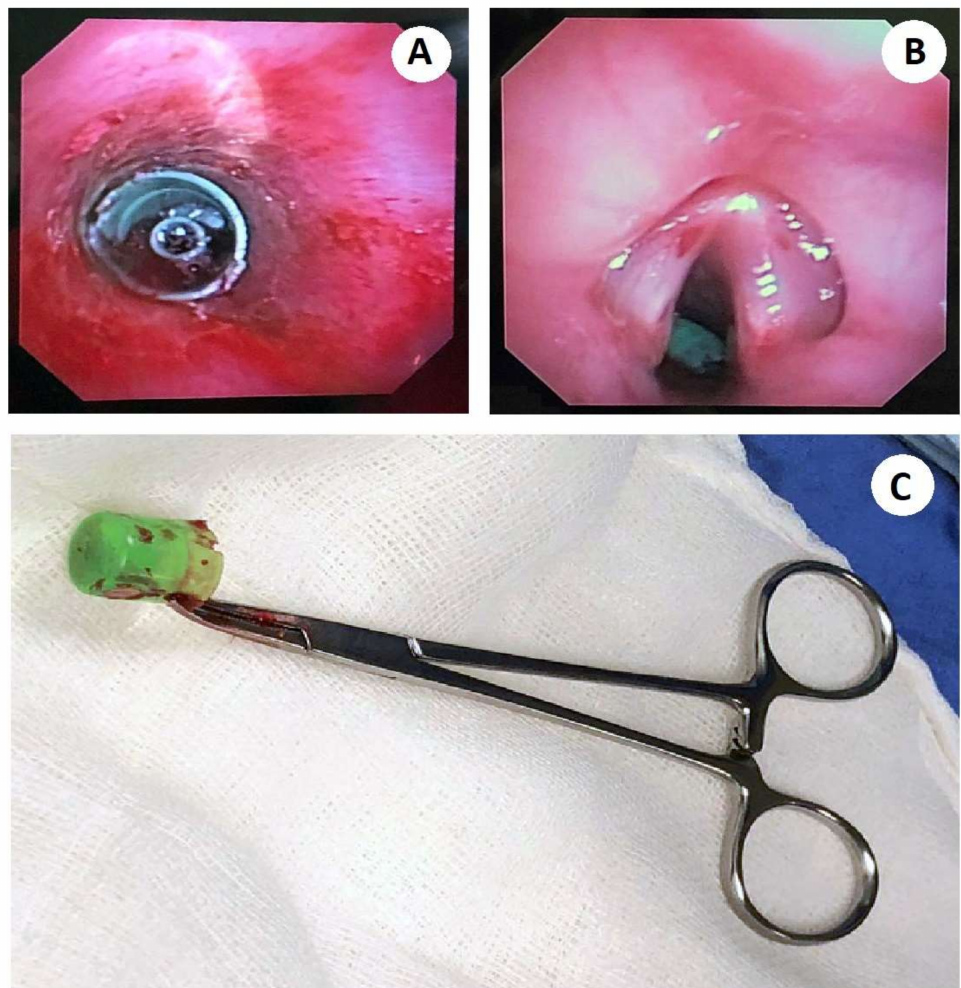
Figure 2. ( A ) Flexible bronchoscopy shows a tracheal FB with an evident near-total airway obstruction. The edematous trachea can be seen, with hyperemic mucosa and blood dotting. ( B ) Endoscopic view of the epiglottis, where the presence of edema is observed. The FB trapped in the subglottic space can be observed. ( C ) The photograph shows the foreign body extracted under flexible bronchoscopy turned out to be a plastic spray cap, cylindrical in appearance, with an approximate diameter of 1 cm, and a length of 2